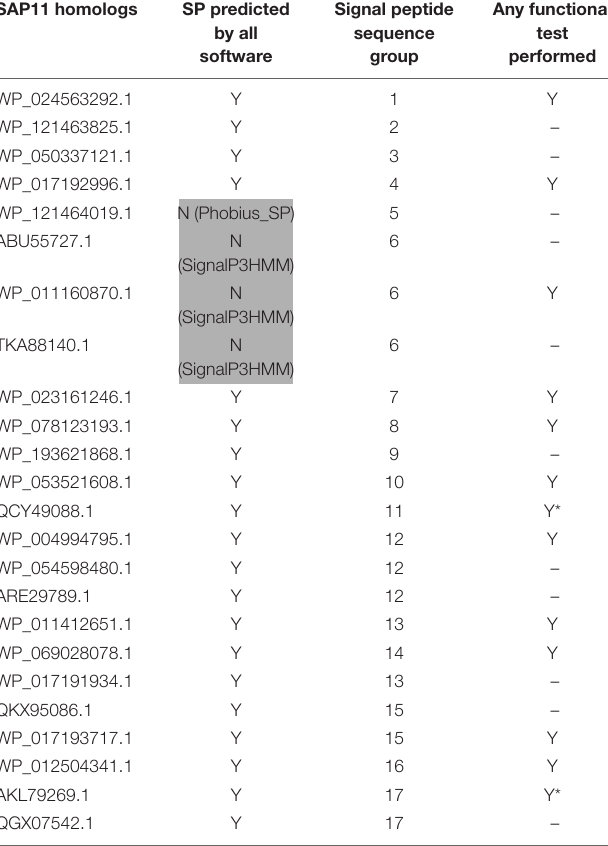
TABLE 3 | SAP54 homologs used in this study. SAP54 homologs SP predicted